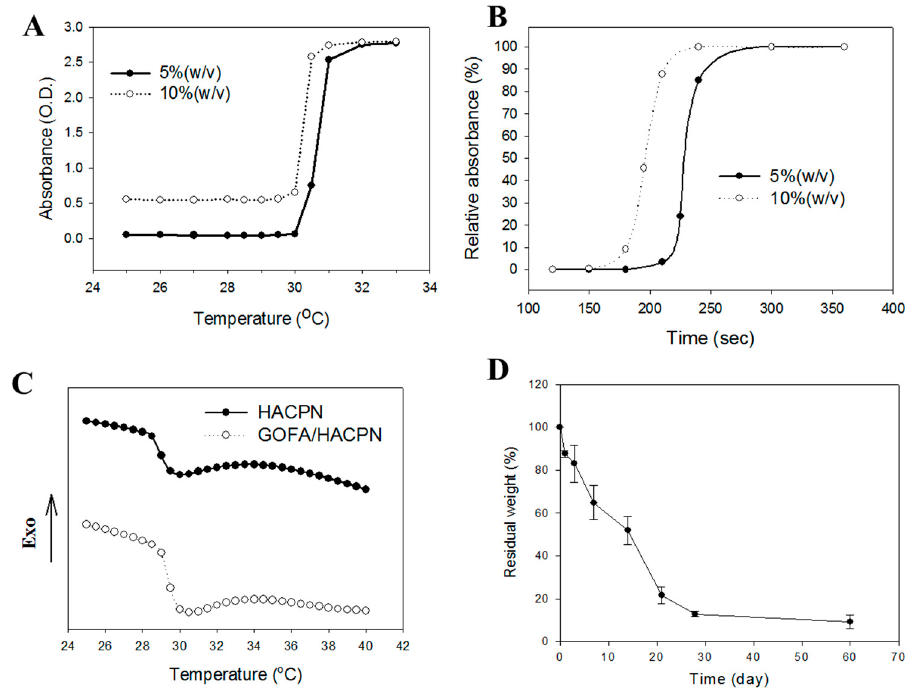
Figure 3. ( A ) Phase transition behavior of thermo-sensitive polymer HACPN at 5% and 10% ( w / v ) from 25 to 33 °C; ( B ) Kinetics of phase transition of 5% and 10% ( w / v ) HACPN solutions during heating with instantaneous temperature change from 25 to 37 °C; ( C ) Thermal properties of HACPN and GOFA/HACPN with 0.1% ( w / w ) GOFA from differential scanning calorimetry; ( D ) The weight loss of 10% ( w / v ) HACPN in pH 7.4 PBS at 37 °C.